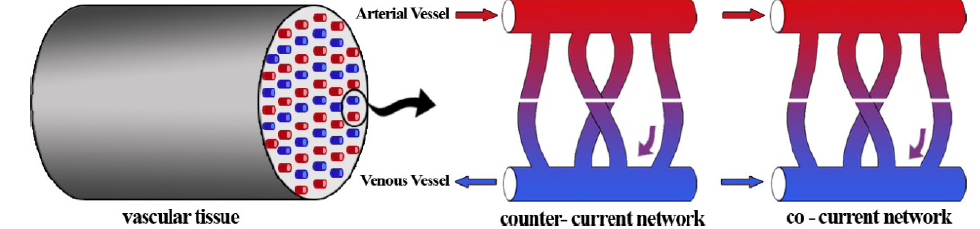
Figure 29. Blood flow throughout vascular tissue-like porous medium studied by Hassanpour and Saboonchi